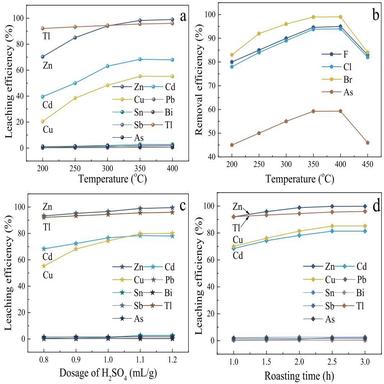
Effect of (a) roasting temperature (H2SO4 dosage = 0.8 mL/g, t = 2 h); (c) H2SO4 dosage (T = 350 ◦C, t = 2 h), (d) roasting time (T = 350 ◦C, H2SO4 dosage = 1.1 mL/g, t = 2 h) on leaching efficiency of valuable and toxic elements, and (b) roasting temperature (H2SO4 dosage = 1.1 mL/g, t = 2 h) on the removal efficiency of F, Cl, Br, and As.